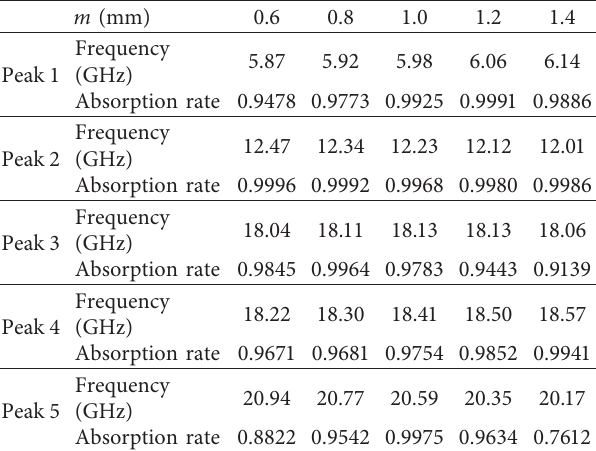
Table 3: Peaks corresponding to parameter m